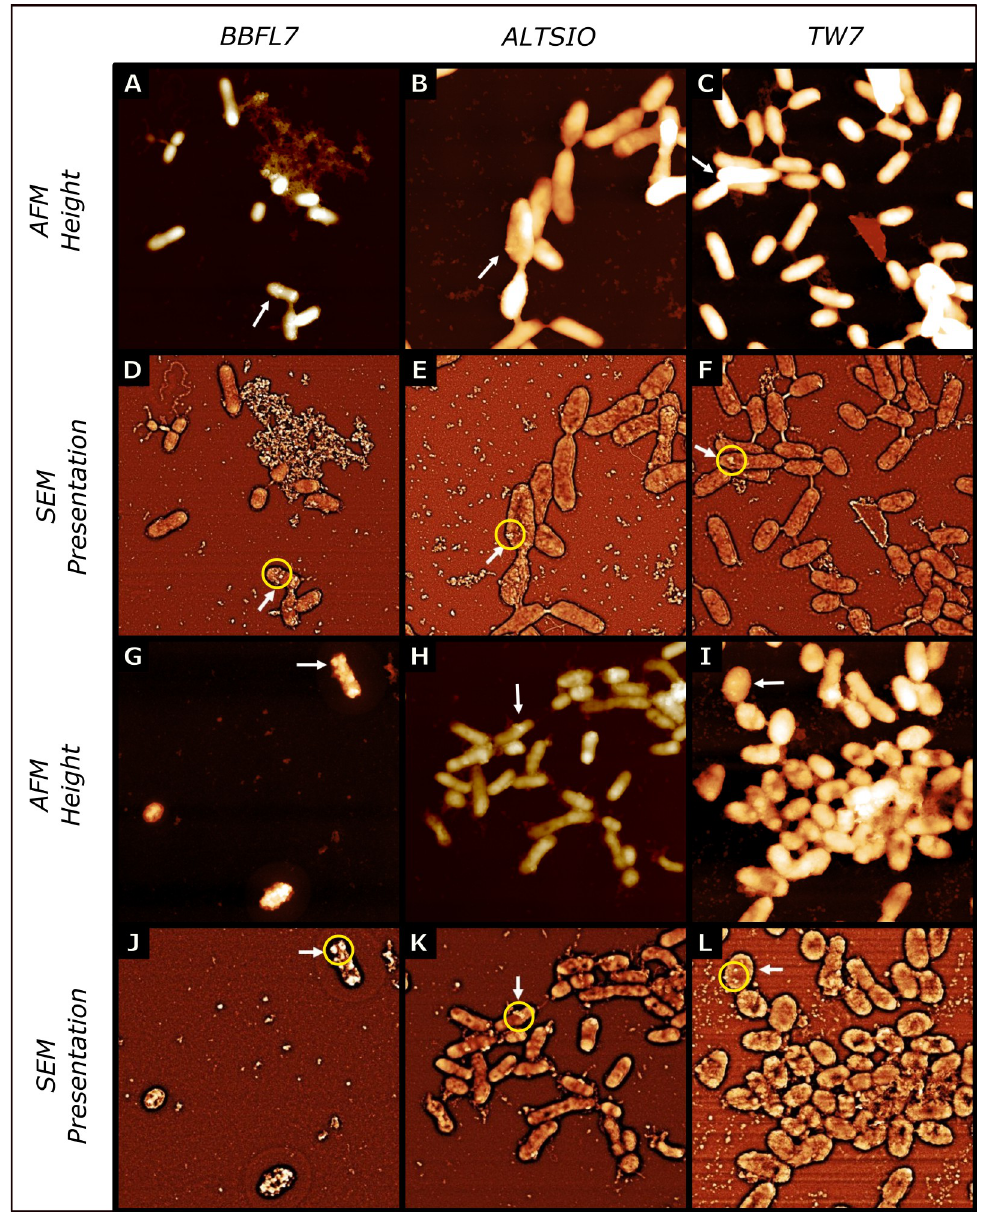
Fig 1. Particle clusters and patches on bacteria surfaces. AFM height images and respective SEM presentations of bacterial isolate surfaces during longer amendment with circulating ribosomes. Flavobacterium sp. BBFL7 (A,D,G,J) , Alteromonas sp. ALTSIO (B,E,H,K) , and Pseudoalteromonas sp. TW7 (C,F,I,L) . The images show prominent surface patches of organic particles (white arrows) on select cells after exposure to ribosomes for 1 h (A-F) and for 4.5 h (G-L) . Panel image scan sizes are 10 μ m × 10 μ